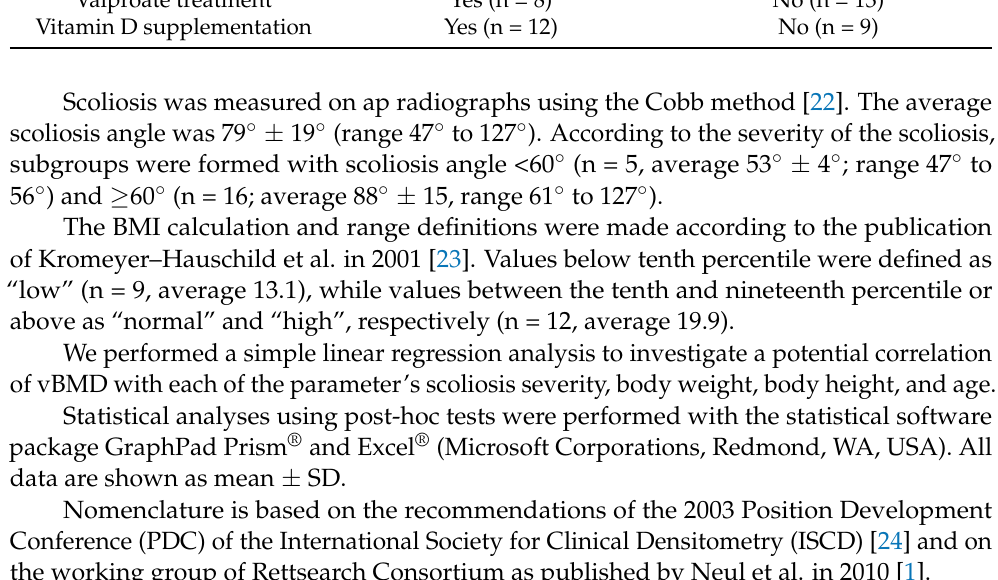
Table 1. Main criteria for defining subgroups of RTT girls for statistical analysis of an eventual influence on vBMD. Total number of participants for each factor n = 21. Valproate was the only antiepileptic drug with relevance in the analysis and is thus included. Further non-relevant drugs were lamotrigine, levetiracetam, oxcarbazepine, perampanel sultiam, and zonisamide. Factors RTT Patients Criterium-Based Subgrouping Scoliosis angle <60 ◦ (n = 5) ≥ 60 ◦ (n = 16) Body mass index (BMI) Low (n = 9) Normal/high (n = 12) Ambulation Yes (n = 12) No (n = 9) Valproate treatment Yes (n = 8) No (n = 13) Vitamin D supplementation Yes (n = 12) No (n = 9) Scoliosis was measured on ap radiographs using the Cobb method [22]. The